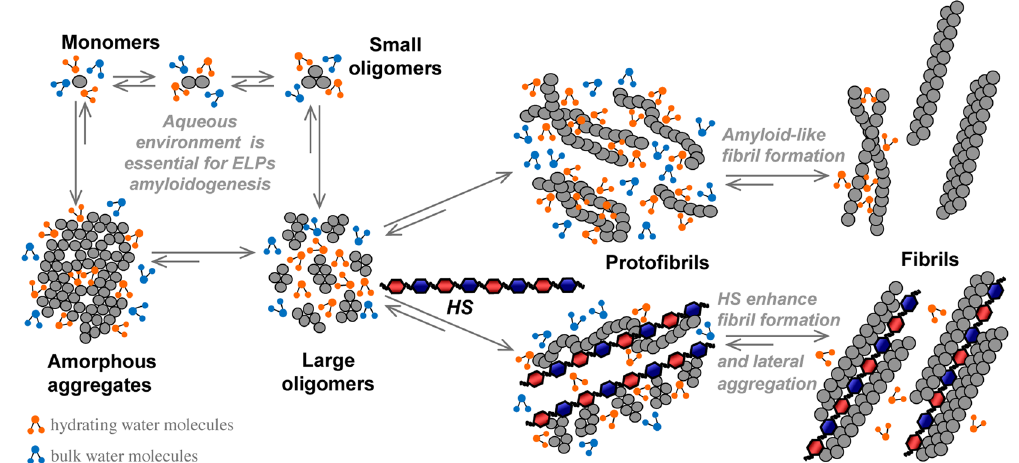
Figure 5. A schematic hypothetical model of HS-mediated enhancement of ELPs self-assembly into amyloid- like fibrils in aqueous environment at 37 °C. Initially, free monomers in solution self-assemble into small and/or large intermediate oligomers and amorphous aggregates acting as nucleation seeds and leading to the formation of protofibrils with different morphology, which merge and intertwine yielding to elongated mature amyloid fibrils. In parallel, higher molecular weight n-HS interact with amyloidogenic intermediates/species more effectively than the lower molecular weight ss-HS. This event can generate a high local concentration of peptides on the HS scaffold that drives the association of amyloidogenic ELPs. Moreover, the hydrophilic nature of HSs may help the β -sheets to associate with one another by sequestering the water molecules through interactions with the disaccharide moieties. The final result of these events combined with the accelerated release of water previously trapped in protofibrils may explain the different acceleration of the overall aggregation pathway leading to amyloid fibril formation, the marked enhancement of their lateral aggregation in more packed fibrillar assemblies as well as the differences in cell adhesion on fibrillar coated